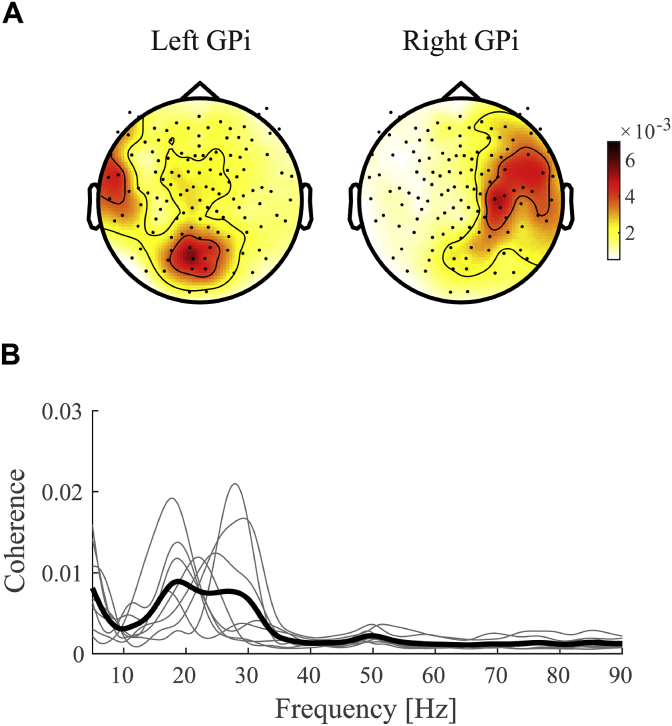
Grand-average coherence. A) Topographies of beta coherence (13–30 Hz) for left and right GPi separately. Shown is the average across the -3 to 3s time interval and all subjects. Red colors indicate larger coherence values. B) Coherence spectra for each individual subject (thin lines) and the grand average (thick line). Spectra are averaged across selected LFP-MEG channel combinations, hemispheres, and conditions.